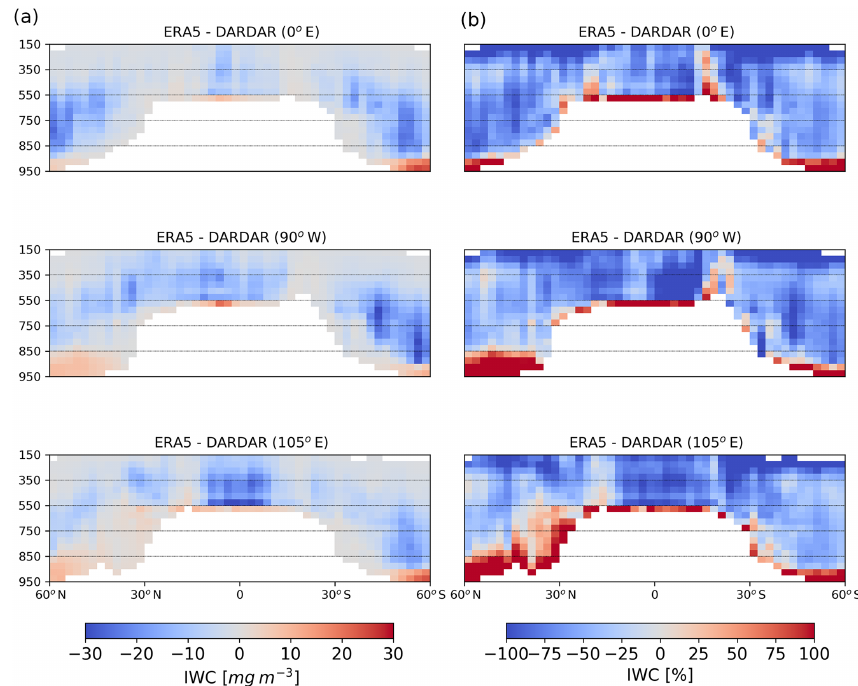
Figure 5. Profile differences in IWC between ERA5 and DARDAR as in Fig. 4. Panels (a) show differences in IWC, while panels (b) show percent